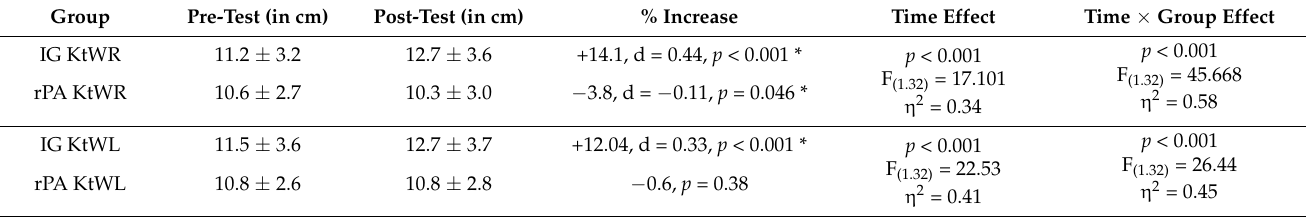
Table 4. Provides descriptive statistics, percentage increases, and time effect and time × group interaction effects for ROM measured via KtW, data presented as means ±